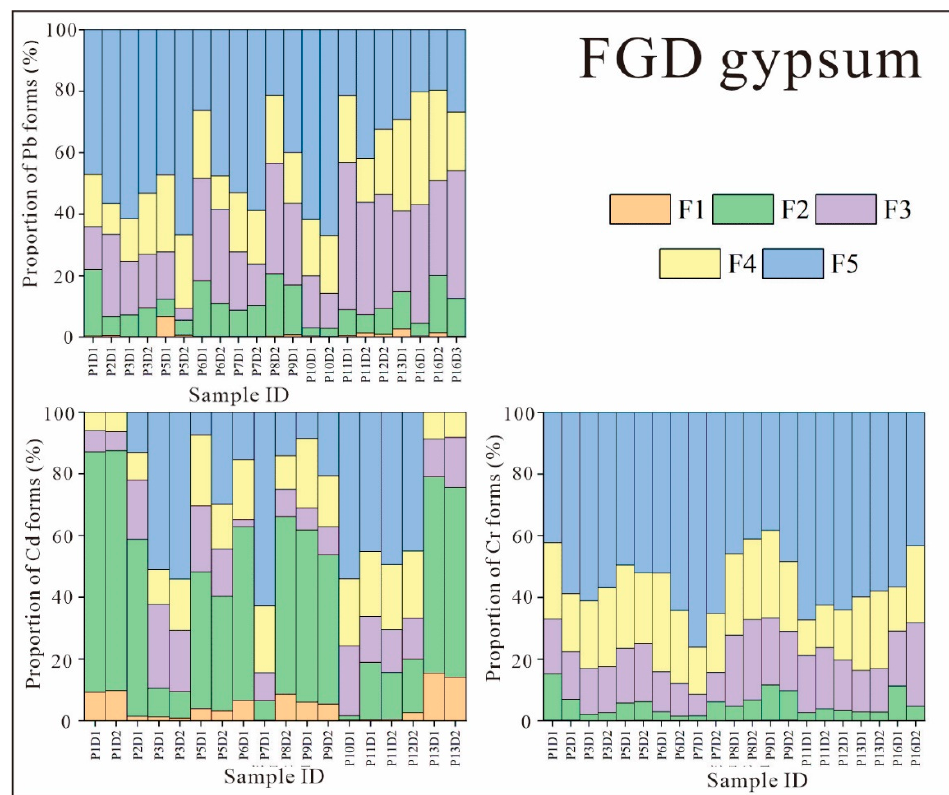
Figure 4. Proportion of different heavy-metal forms in the FGD gypsum samples from CFPPs in Guizhou Province (CFPP ID: P: plant ID; E: fly ash collected from ESP; F: fly ash collected from FF.).